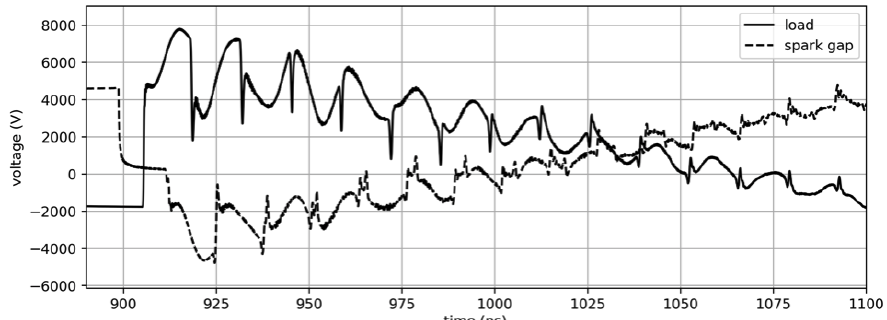
Figure 9. Voltage waveforms on the antenna terminals (load) and the